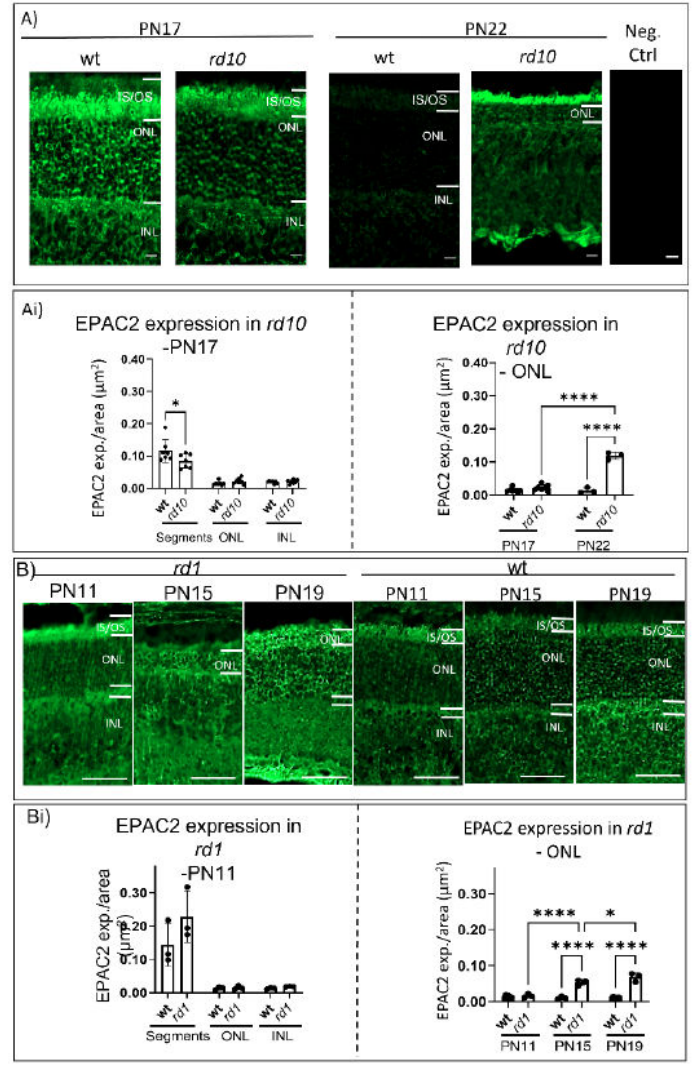
Figure 2. EPAC2 expression in the rd models compared to their respective wt retina. ( A , B ) Example of EPAC2 immunostaining, in this case, rd10, rd1, and wt retina at different ages (i.e., wt/ rd10: PN17, and PN22, wt/ rd1: PN11, PN15, and PN19). A negative control with no primary EPAC2 antibody is provided. Scale bar: ( A ) 10 µ m and ( B ) 50 µ m. Panel ( Ai ) EPAC2 expression analyses in rd10. Left for the different layers: segments (IS/OS), ONL, and INL; right data from relevant ages for rd10 and their respective wt counterparts. ( Bi ) EPAC2 expression analyses in rd1. Left for the different layers: segments (IS/OS), ONL, and INL; right data from relevant ages for rd1 and their respective wt counterparts. The EPAC2 expression was generally higher within the segments, and with respect to these, rd10 had less EPAC2 expression than wt. The ONL and INL values were all significantly different from the segment values of the corresponding genotype (not labeled in the figure). Furthermore, data show EPAC2 expression increases significantly over time in both models. ( A , B ) Graphs represent three to seven biological replicates with mean ± SD; the two-way ANOVA was applied, and the levels of significance are * p < 0.05, **** p < 0.0001. Abbreviations the same as in Figure